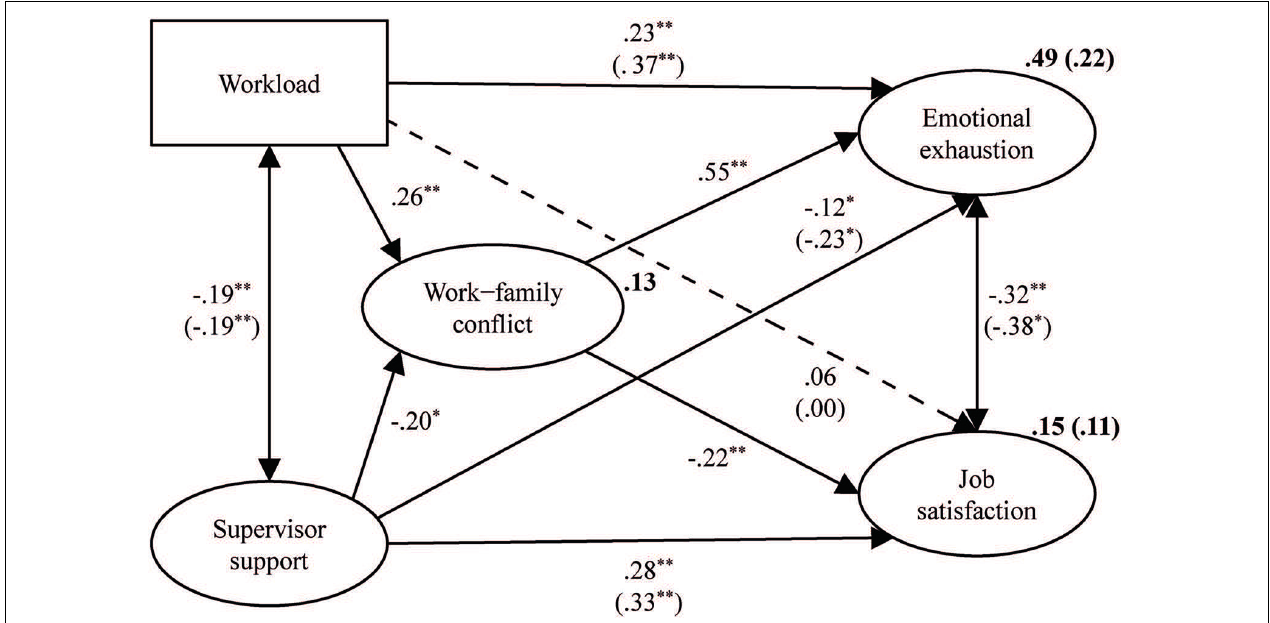
FIGURE 2 | Maximum likelihood (ML) estimates for Model M 1 ( N = 1,127). The standardized regression weights of Model M 0 are depicted in parentheses. The broken line represents a non-significant effect. Amounts of explained variance are depicted in bold print. Workload is represented by a rectangle, because the single item was integrated into the model as a manifest variable. The standardized indirect effects of workload on emotional exhaustion (0.14, p = 0.006) and supervisor support on job satisfaction (0.05, p = 0.009) were statistically significant. ∗ p ≤ 0.05, ∗∗ p ≤ 0.01.